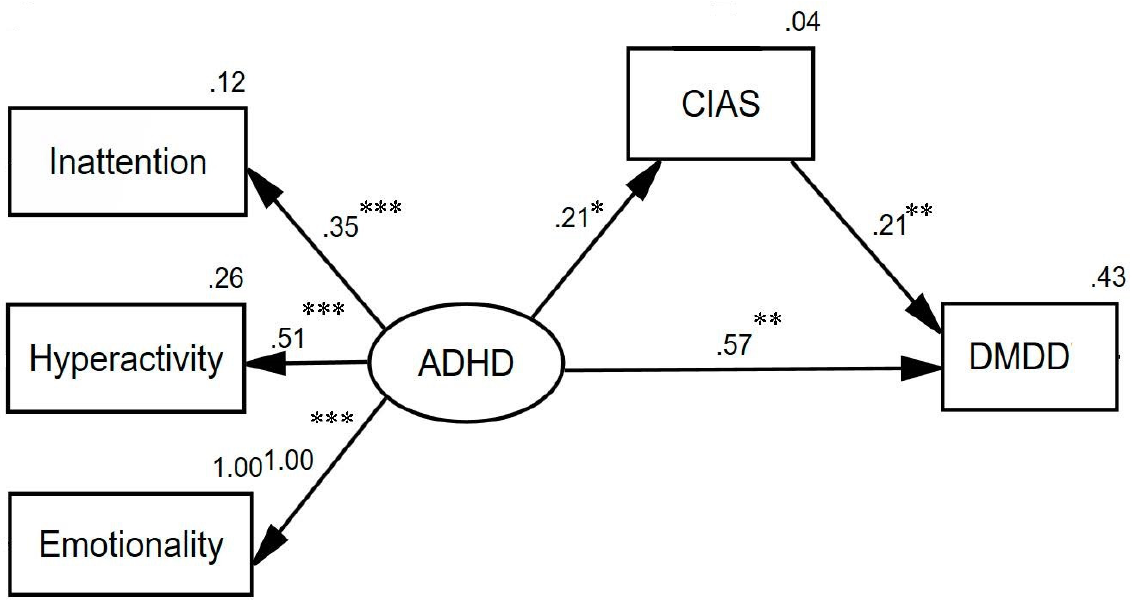
Figure 2. The mediation models. Circles represent unobserved latent variables. Rectangles represent observed measured variables. Values are standardized path coefficients. Goodness-of-fit indicators: Chi-Square = 1.087 ( p = 0.297), SRMR = 0.026, RMSEA = 0.029, GFI = 0.996, IFI = 0.999, CFI = 0.999, NFI = 0.992, and TLI = 0.993. * p < 0.05, ** p < 0.01, and *** p < 0.001. ADHD: attention-deficit/hyper-